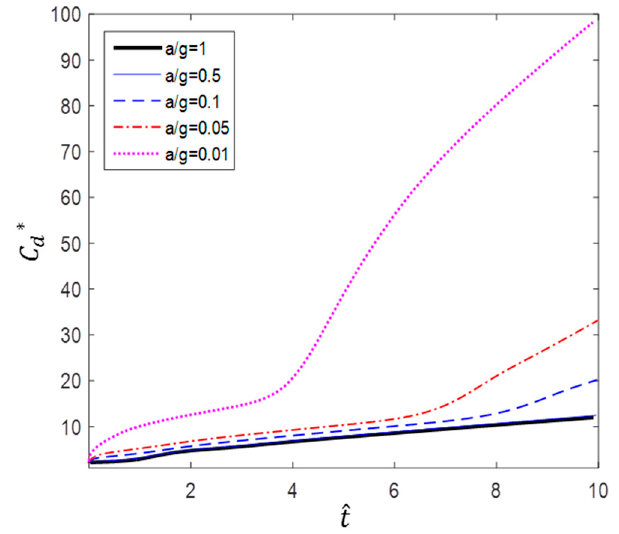
Figure 10. Dimensionless time variation of drag coe ffi cient C d ∗ ( Re 0 = 40 )